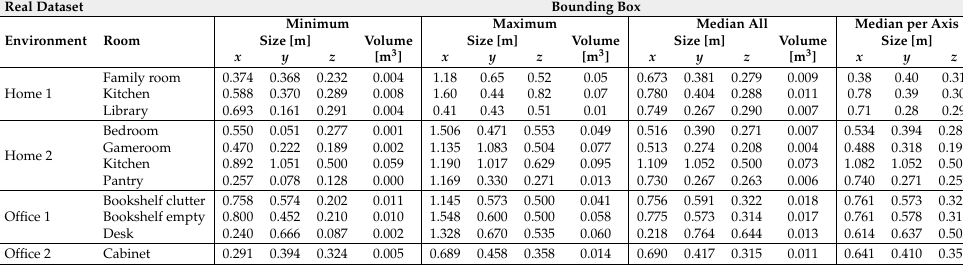
Table 4. Minimum, maximum, and median storage volumes with corresponding size in each direction for each room in the real dataset. Column “median per axis” shows the median length, height, and width of each furniture